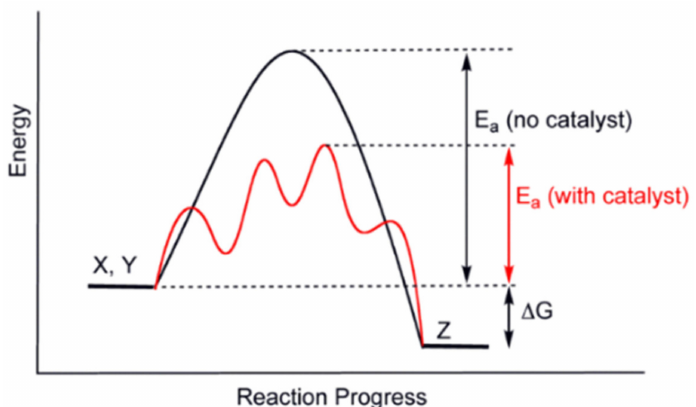
Figure 14. General reaction mechanism of an exothermic reaction (X + Y → Z) with and without catalyst [63]. Copyright 2008, Attribution: No machine-readable author provided. Smokefoot